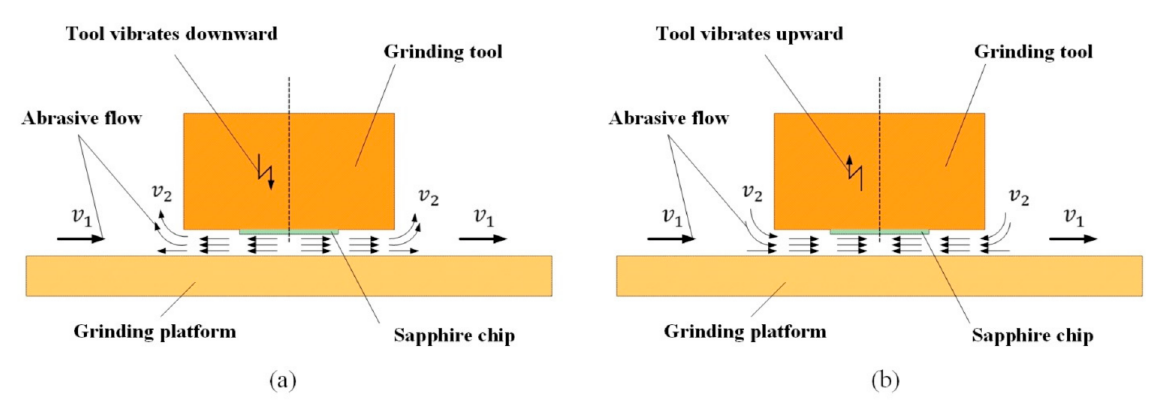
Figure 2. Material removal principle of abrasive fluid shear flow in ( a ) the first half vibration period, and ( b ) the second half vibration